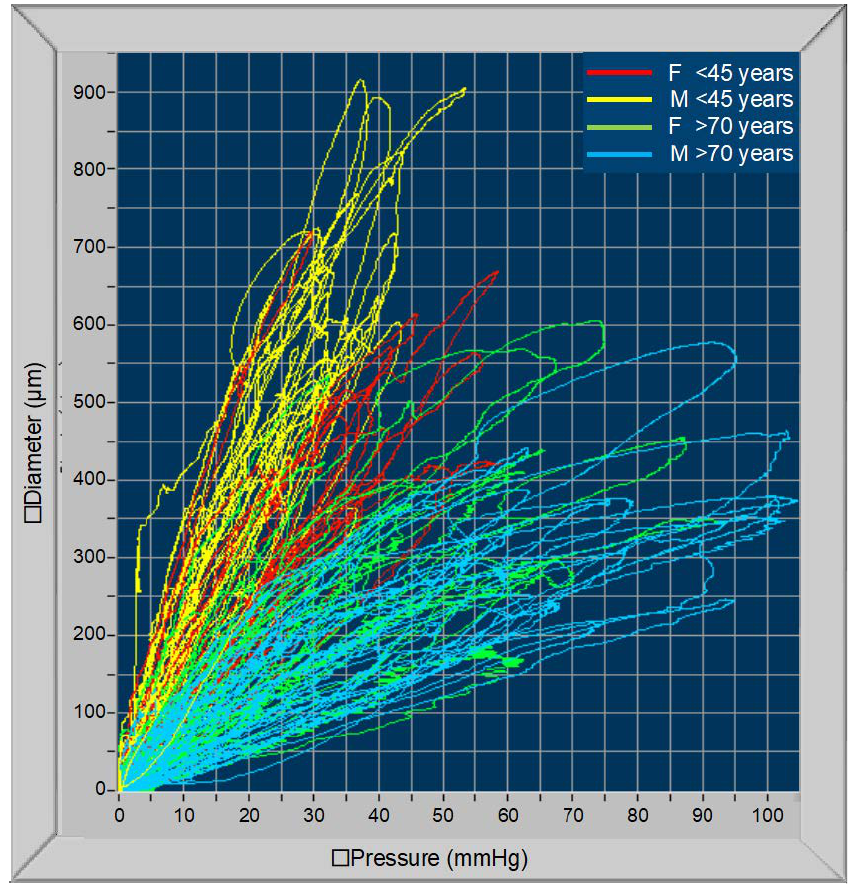
Figure 3. Carotid cross-section pressure curves in individuals aged 20–45 years (red lines, females; yellow lines, males) and over 70 years old (green lines, females; blue lines, males).